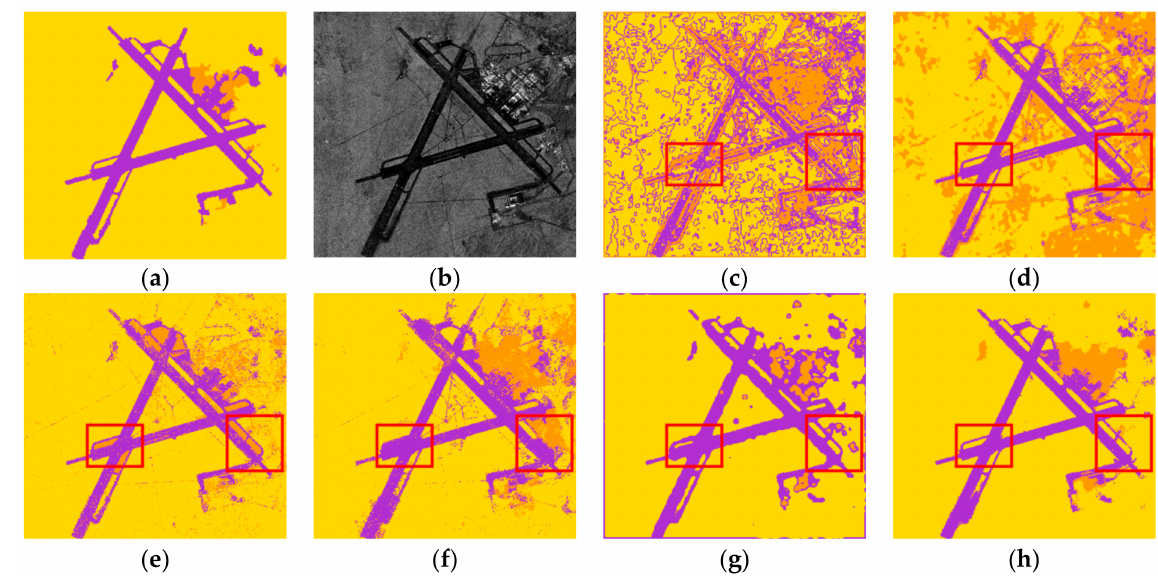
Figure 5. Results of a real SAR image: ( a ) ground truth; ( b ) real SAR image; ( c ) SVM; ( d ) CKS-FCM; ( e ) CKFF; ( f ) SVM-CK; ( g ) MWSG; ( h ) MAKC.